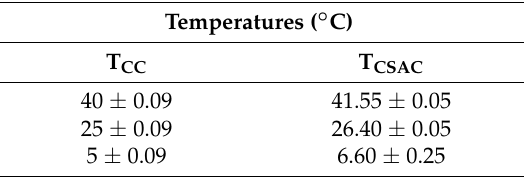
Table 4. CC temperature